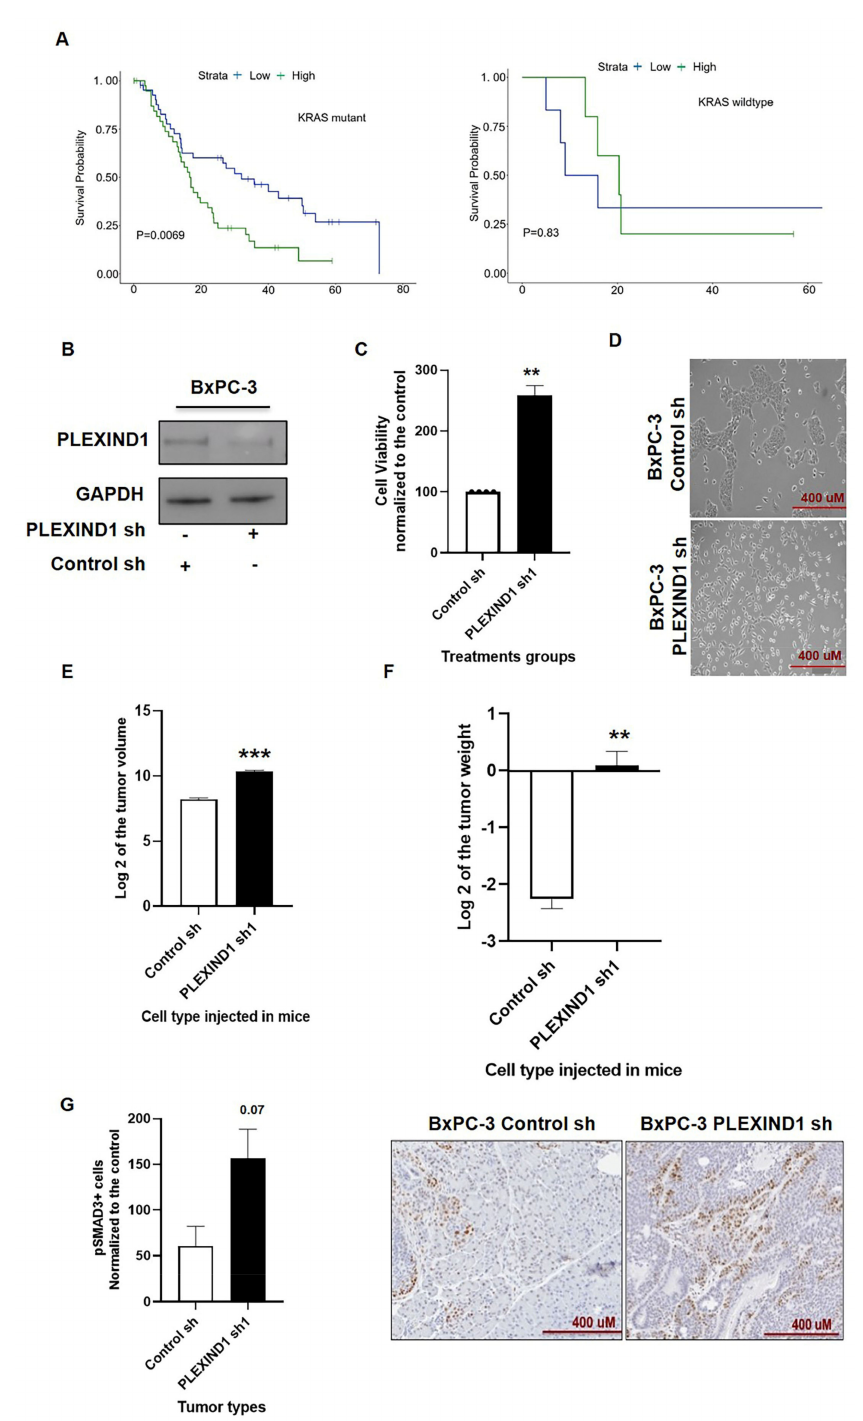
Figure 6. PLEXIND1 acts as a tumor suppressor in KRASwt PDAC cell line BxPC-3. ( A ): Survival probability analysis of pancreatic ductal adenocarcinoma (PDAC) patients with mutant and wild-type KRAS with respect to PLEXIND1 expression. ( B ): Western blot analysis showing reduced expression of PLEXIND1 upon shRNA treatment. ( C ): Cell viability assay for BxPC-3 cells with reduced PLEXIND1 expression grown for 72 h. Data are plotted as a percentage of control cells (transfected with control shRNA). ( D ): Representative images showing the morphological changes in BxPC-3 cells on PLEXIND1 knockdown. ( E , F ): Log2 values of tumor volumes and weights from orthotropic mice models implanted with BxPC-3 cells with PLEXIND1 knockdown ( G ): Quantification of digital images for pSMAD3 at 20X magnification ( n = 3). Significant differences: * p < 0.05 vs control, ** p < 0.01 vs control, *** p < 0.001 vs control, **** p < 0.0001 vs control. Error bars represent standard error of the